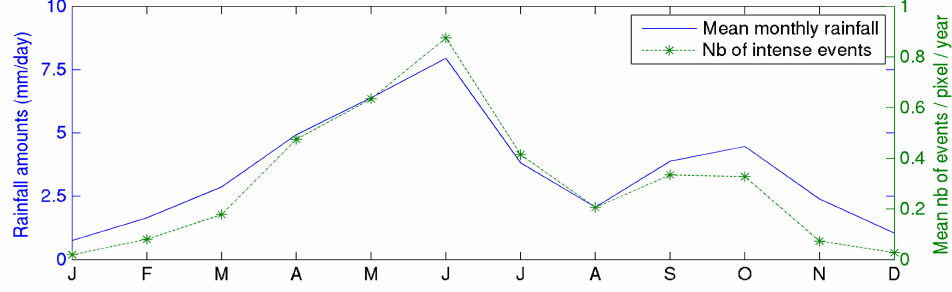
Figure 4. Mean monthly rainfall and number of intense rainfall events averaged over the study area (4–8 ◦ N, 7 ◦ W–3 ◦ E TRMM